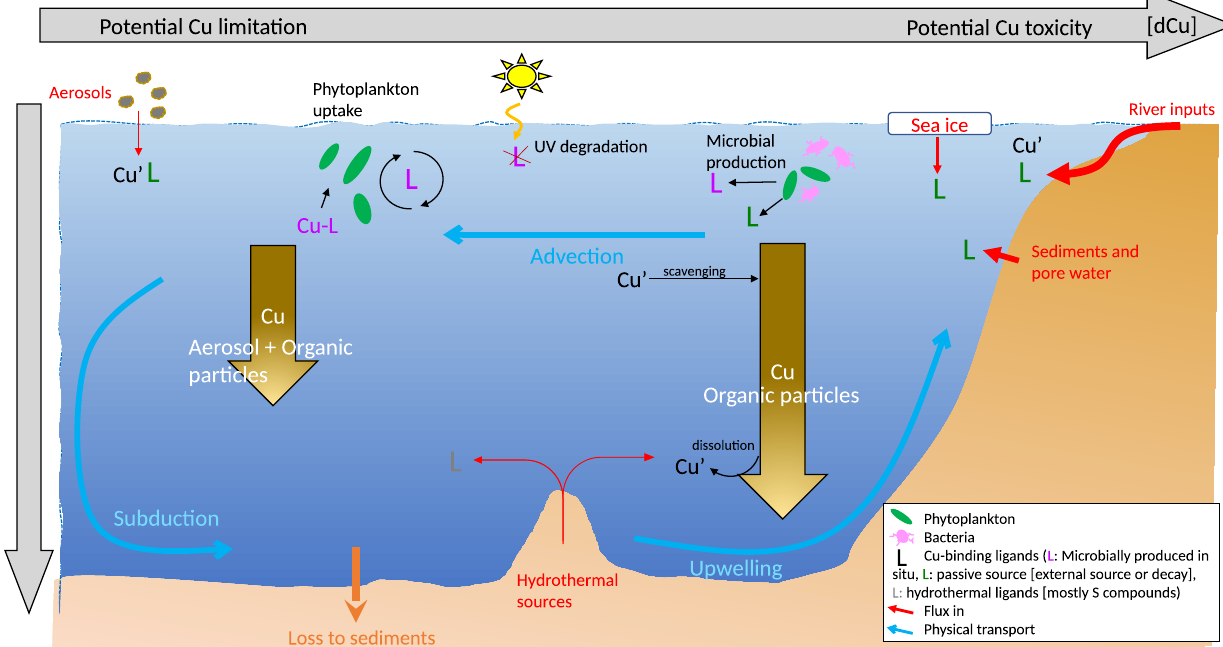
Fig. 4 Current understanding of the cycling of organic copper-binding ligands in the ocean. Schematic of copper-binding ligand cycling in the global ocean. Source fl uxes that have been included in Table 4 are shown as red arrows, while sink fl uxes that are shown in Table 4 are orange arrows. The fl ux of ligands to sediments is assumed based on assumptions of steady state. Additional ligand sources and sinks where fl ux calculations have not been completed are represented by black arrows. The potential for copper limitation or copper toxicity is shown to generally follow total copper concentrations, with the potential for copper toxicity greatest in coastal regions and the potential for copper limitation being greatest in open-ocean